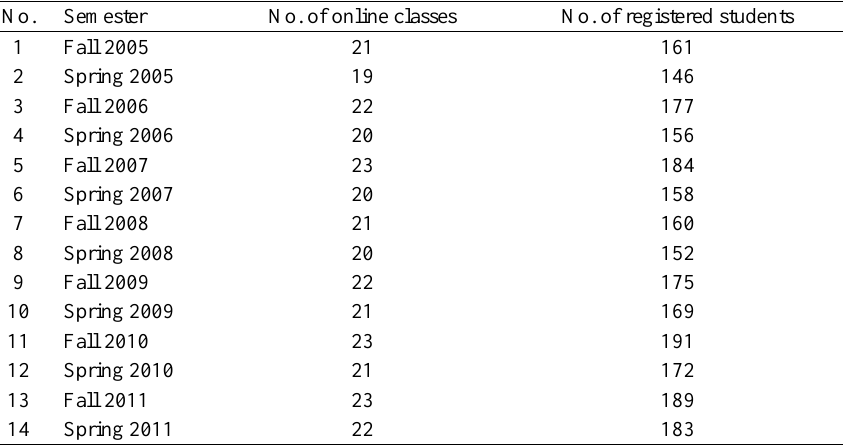
Table 4. The number of online classes and students in each